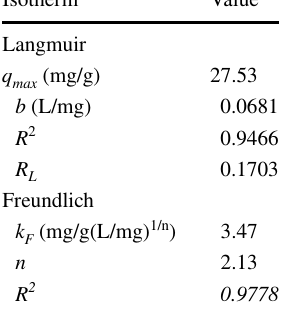
isotherm constants and correlation coefficients for adsorption of Cr(VI) onto LLAC adsorbent